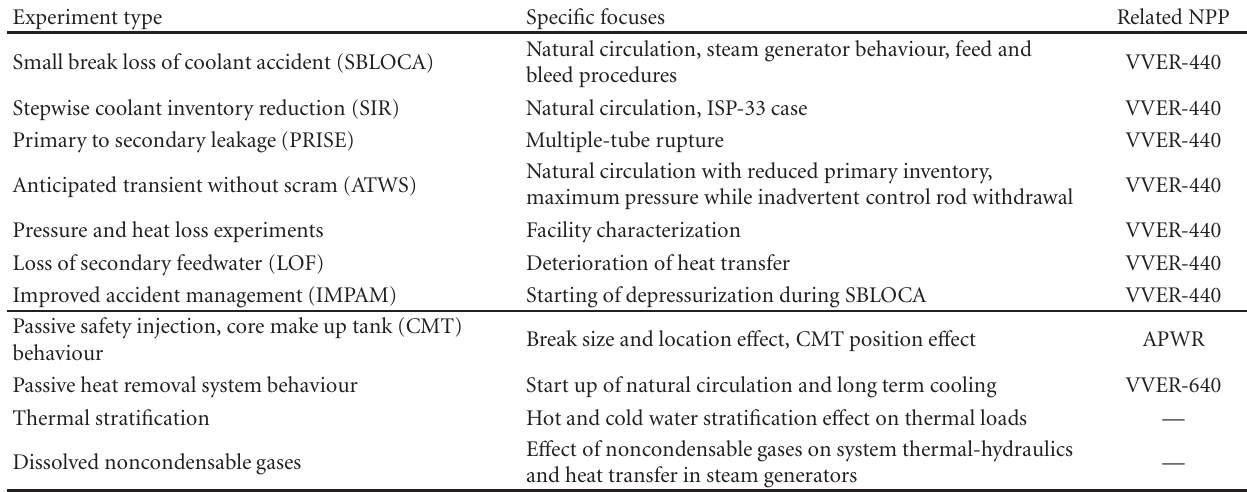
Table 2: PACTEL experiments, examples on performed experiment